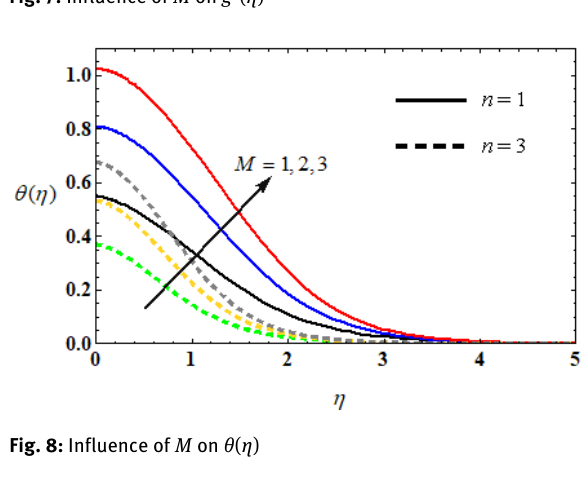
Fig. 7: Influence of M on g (cid:48) ( η )